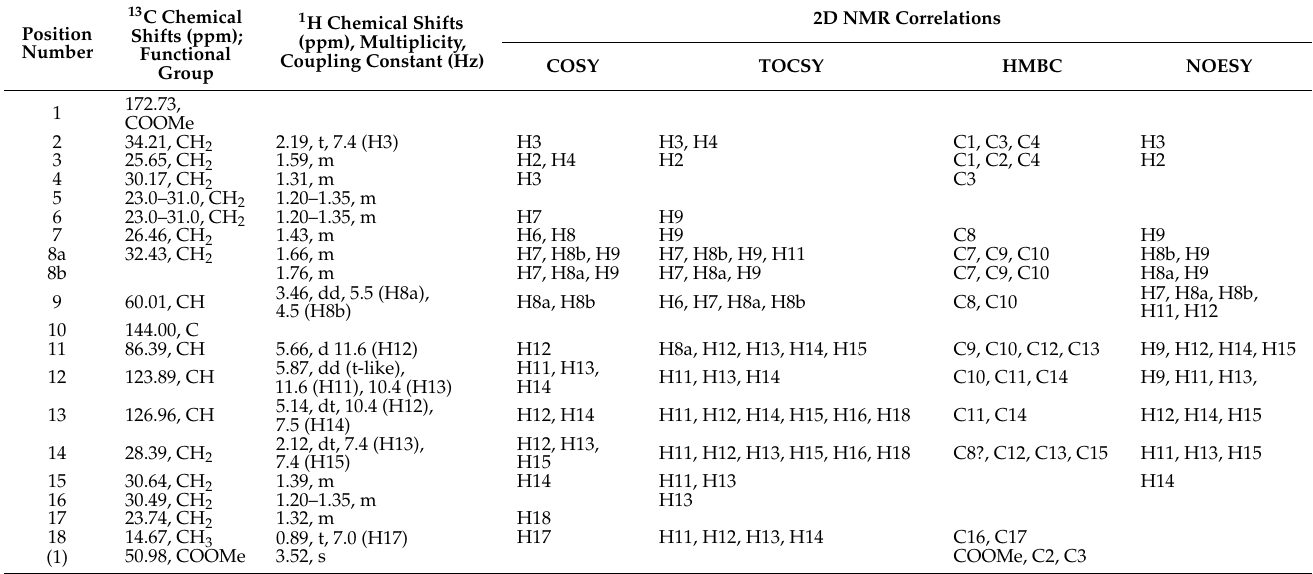
Table 1. The NMR spectral data for 9,10-EOD (Me ester) biosynthesized by ZmAOS (CYP74A19), [ 2 H 14 ]n-hexane, 253 K. The 1 H-NMR (600 MHz), 1 H- 1 H-COSY (600/600 MHz), 1 H- 1 H-TOCSY (600/600 MHz), 1 H- 13 C-HSQC (600/151 MHz), 1 H- 13 C-HMBC (600/151MHz) and 1 H- 1 H-NOESY (600/600 MHz) data are